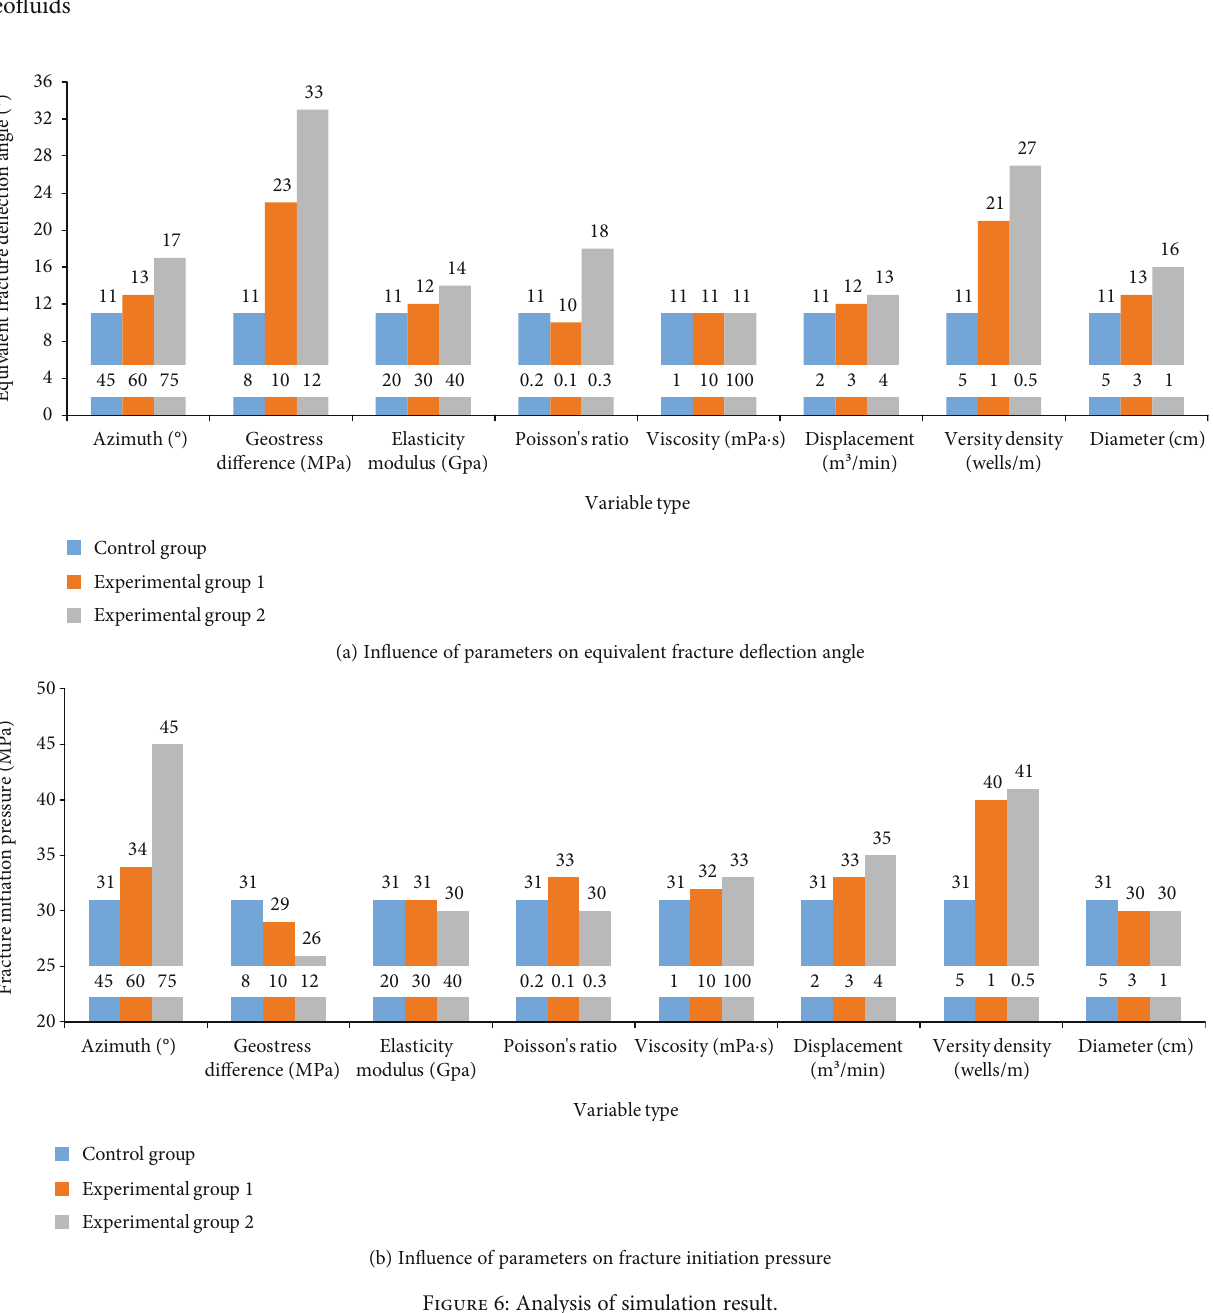
Figure 6: Analysis of simulation